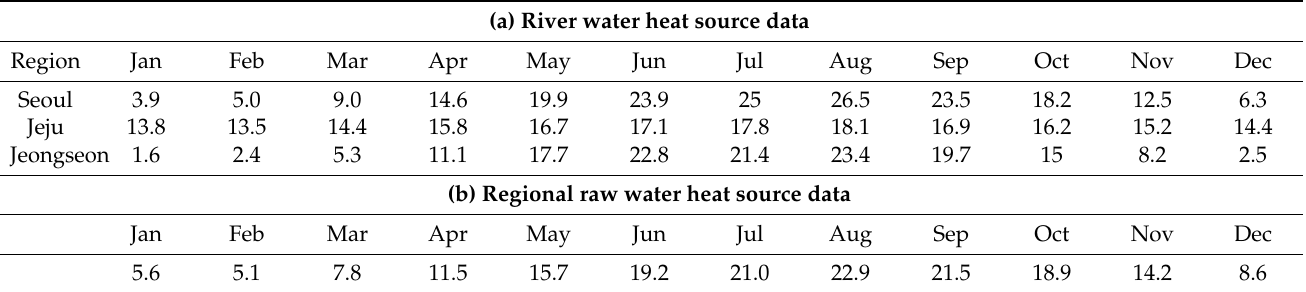
Table 3. Monthly data of the reference river water heat sources.